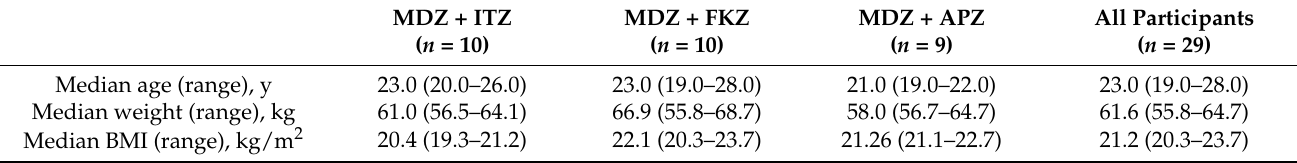
Table 1. Baseline demographic data for all male